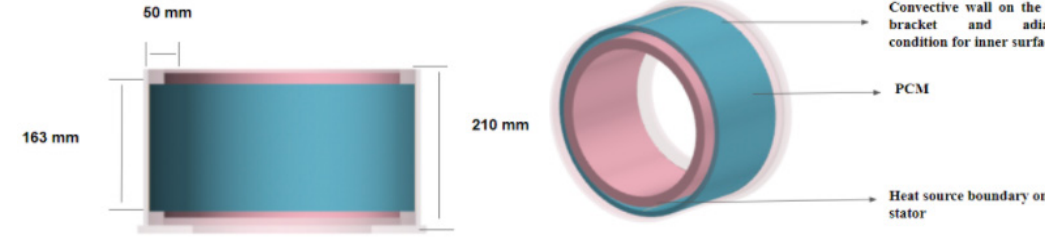
Figure 4. Boundary Definition of E-Machine.